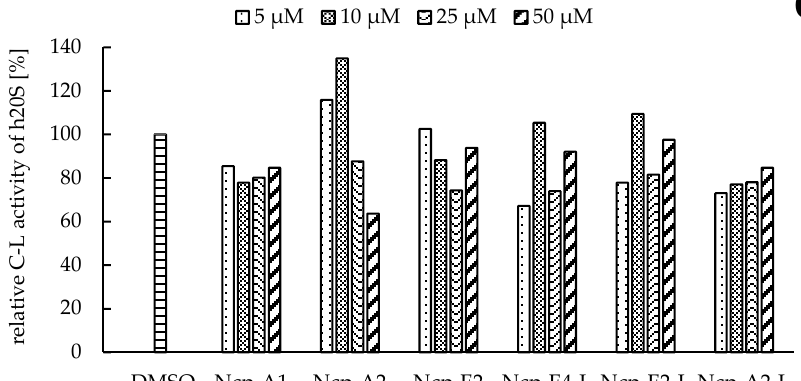
Figure 2. The effects of cyclic and linear (L) nostocyclopeptides (Ncps) on the CT-L ( A ), T-L ( B ), and C-L ( C ) activities of the human 20S proteasome. DMSO was used as a control, and PR11 was used to ensure the correctness of the assay. In the CT-L activity assay, all Ncp variants were tested in triplicate.